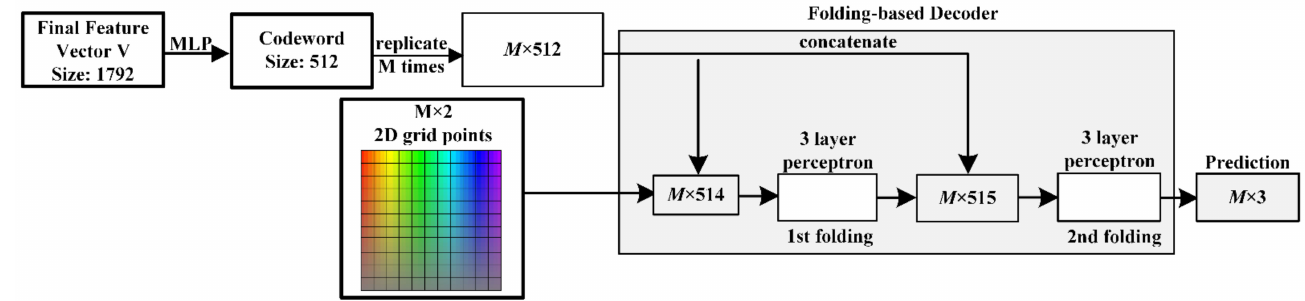
Figure 5. Details of the FBD. First, input the feature vector into the MLP to obtain the codeword used for the folding operation. Then, concatenate the codeword and 2D grid points to obtain the predicted point cloud after two consecutive folding